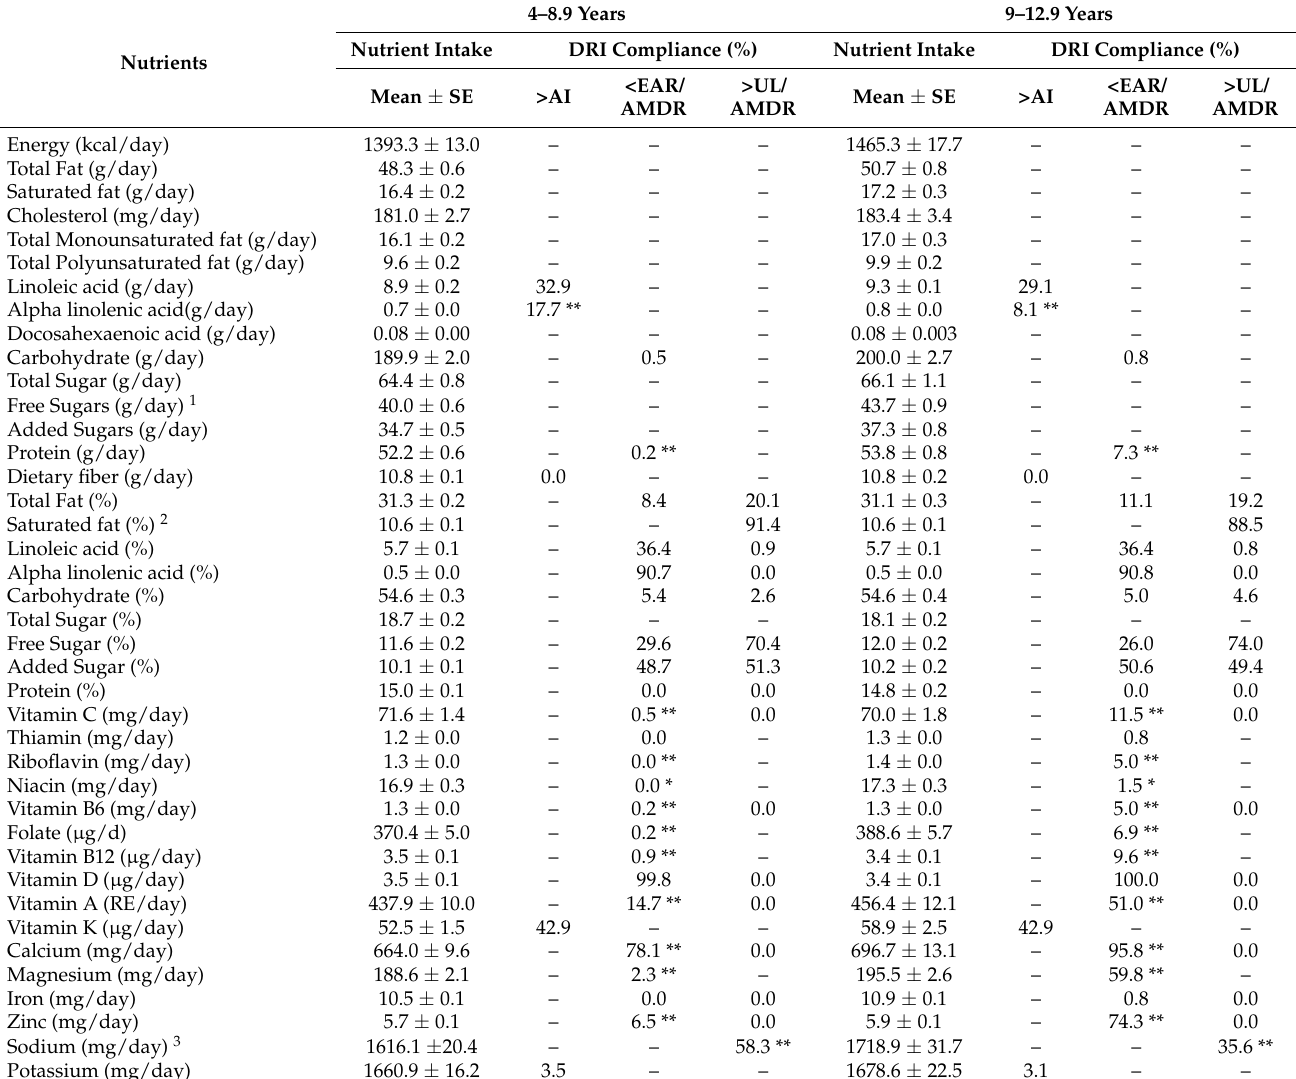
Table 3. Usual Macro and Micronutrient Intake of children Aged 4 to 12.9 Years and Percent Compli- ance with DRIs, KNHS